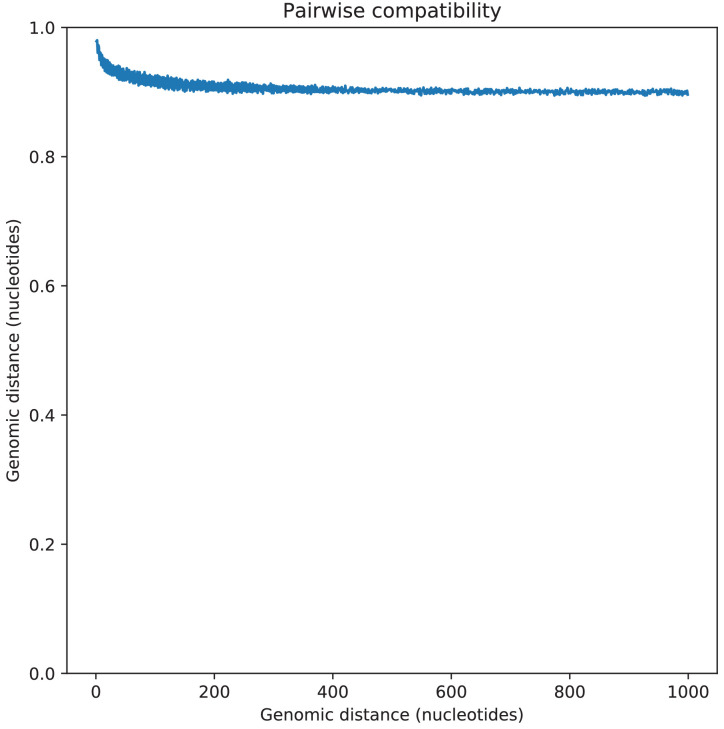
Pairwise SNP compatibility as a function of genomic distance. The plot show the fraction of SNP pairs that are compatible with a common phylogeny as a function of the genomic distance between the pair (in nucleotides).